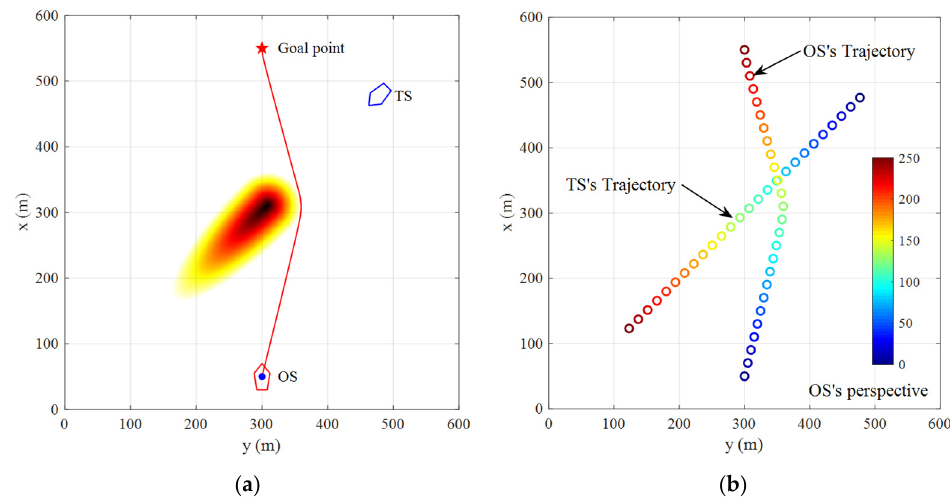
Figure 9. The path planning results and the collision avoidance trajectories in Crossing − 1. ( a ) The path planning results, ( b ) The collision avoidance trajectories.